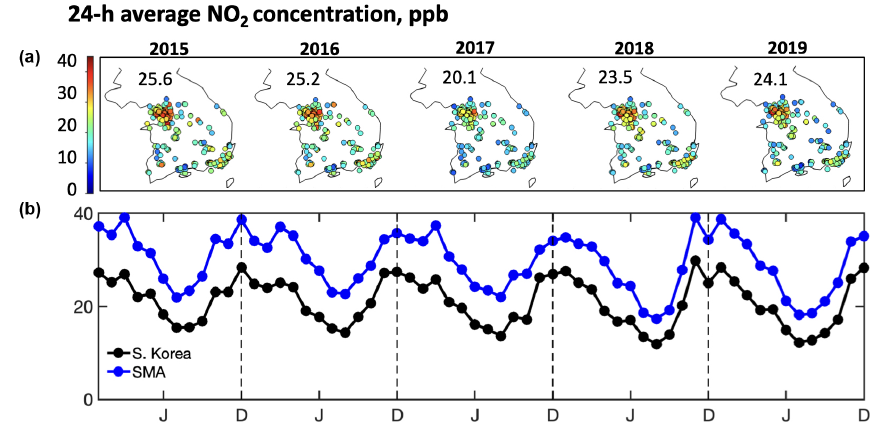
Figure 2. Same as Fig. 1 but for 24h average annual mean NO 2 concentrations.